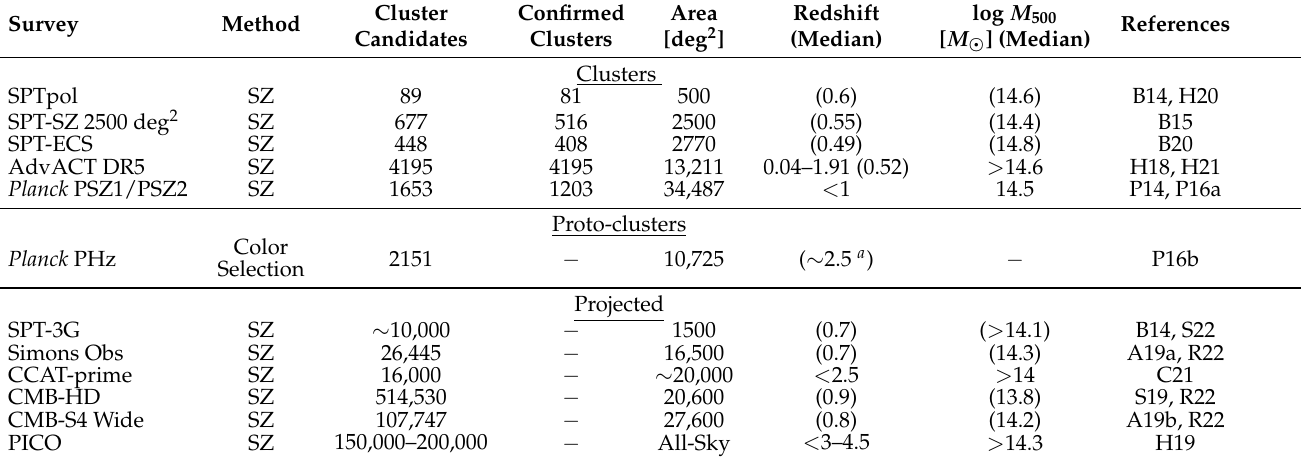
Table 2. A(n Incomplete) List of (Proto-)Cluster Surveys Incorporating FIR and Submm Observations (Section